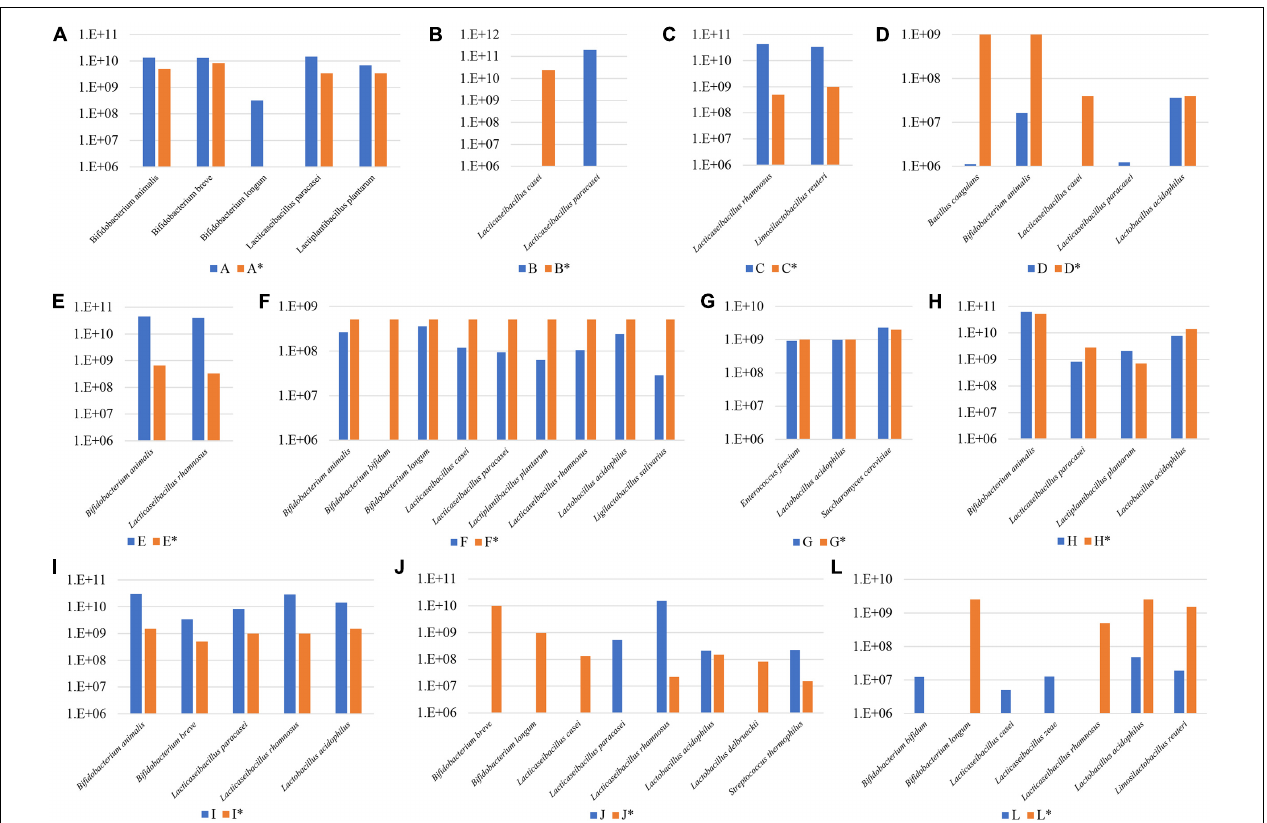
FIGURE 3 | Absolute abundance values for microbes in a variety of probiotic supplements. Panel (A–L) exhibit the absolute abundance of each probiotic species among 11 supplements reported with an identification letter from A to L. Declared viability values of each microbial species is reported in pillars marked with an